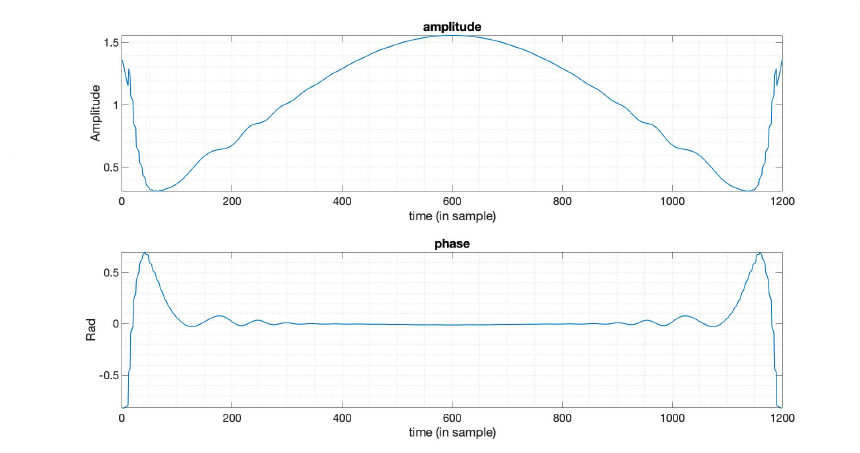
Figure 4. The amplitude and phase of the optimized window function in Figure 3. Table 2. Comparison between output parameters of Taylor window (¯ n = 6,PSLR = − 35 dB) and